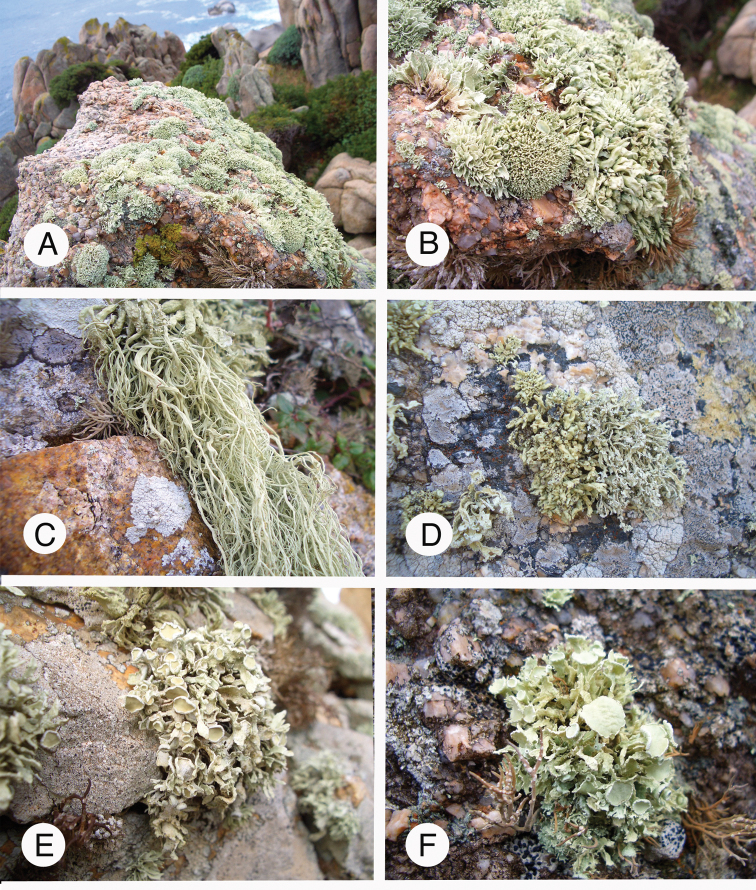
Species of Ramalina on rocky seashores in Italy/Sardinia A general view of species and habitat B from left to right: R.
tingitana, R.
breviuscula and R.
cribrosaCR.
implexaD from left to right: R.
clementeana and R.
requieniiER.
tingitanaFR.
inaequalis. Photographs by M. Guissard and E. Sérusiaux.